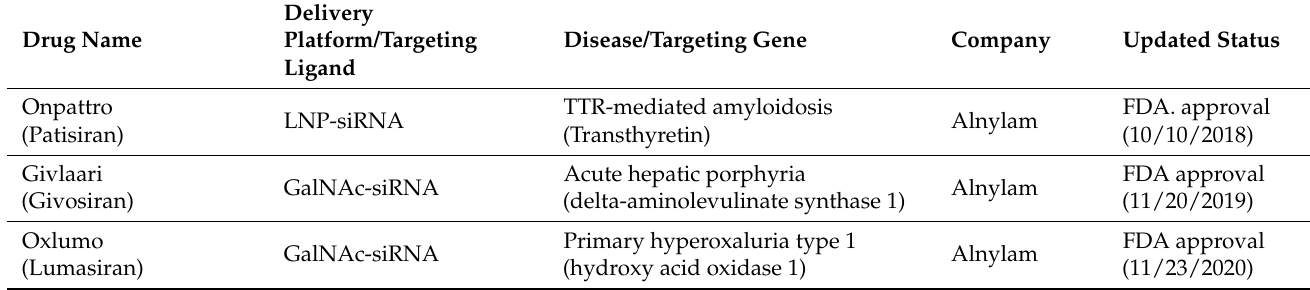
Table 1. Reported approved/Phase III clinical trials of siRNA-based